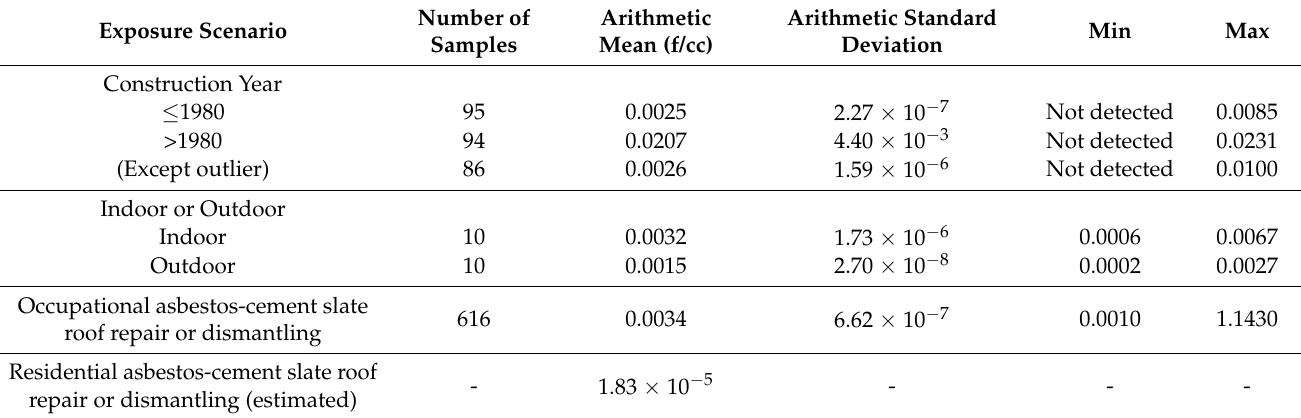
Table 2. Asbestos exposure level by each asbestos-cement slate exposure scenario according to the pooled analysis.